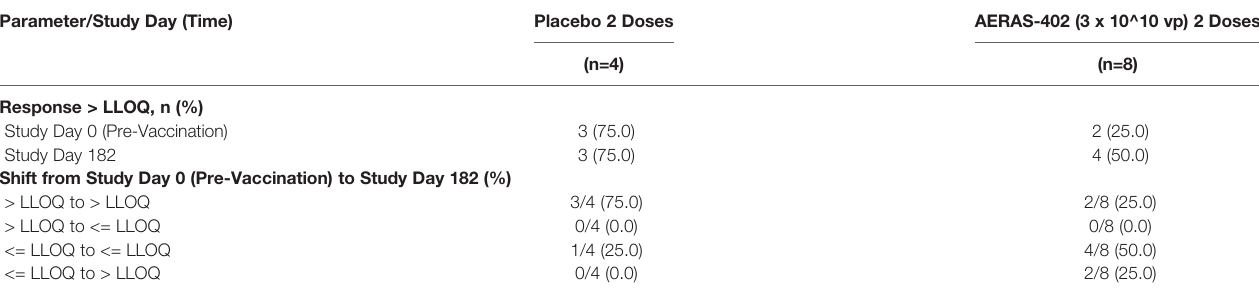
TABLE 3 | AERAS-402 anti-Ad35 Neutralizing Activity.